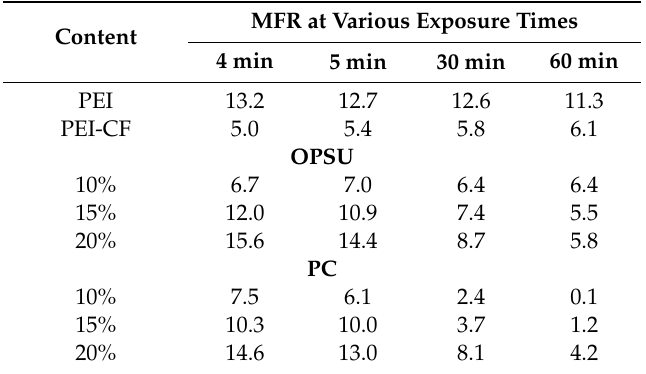
Table 7. Thermo-oxidative stability of carbon-filled PEI with di ff erent content of OPSU and PC.